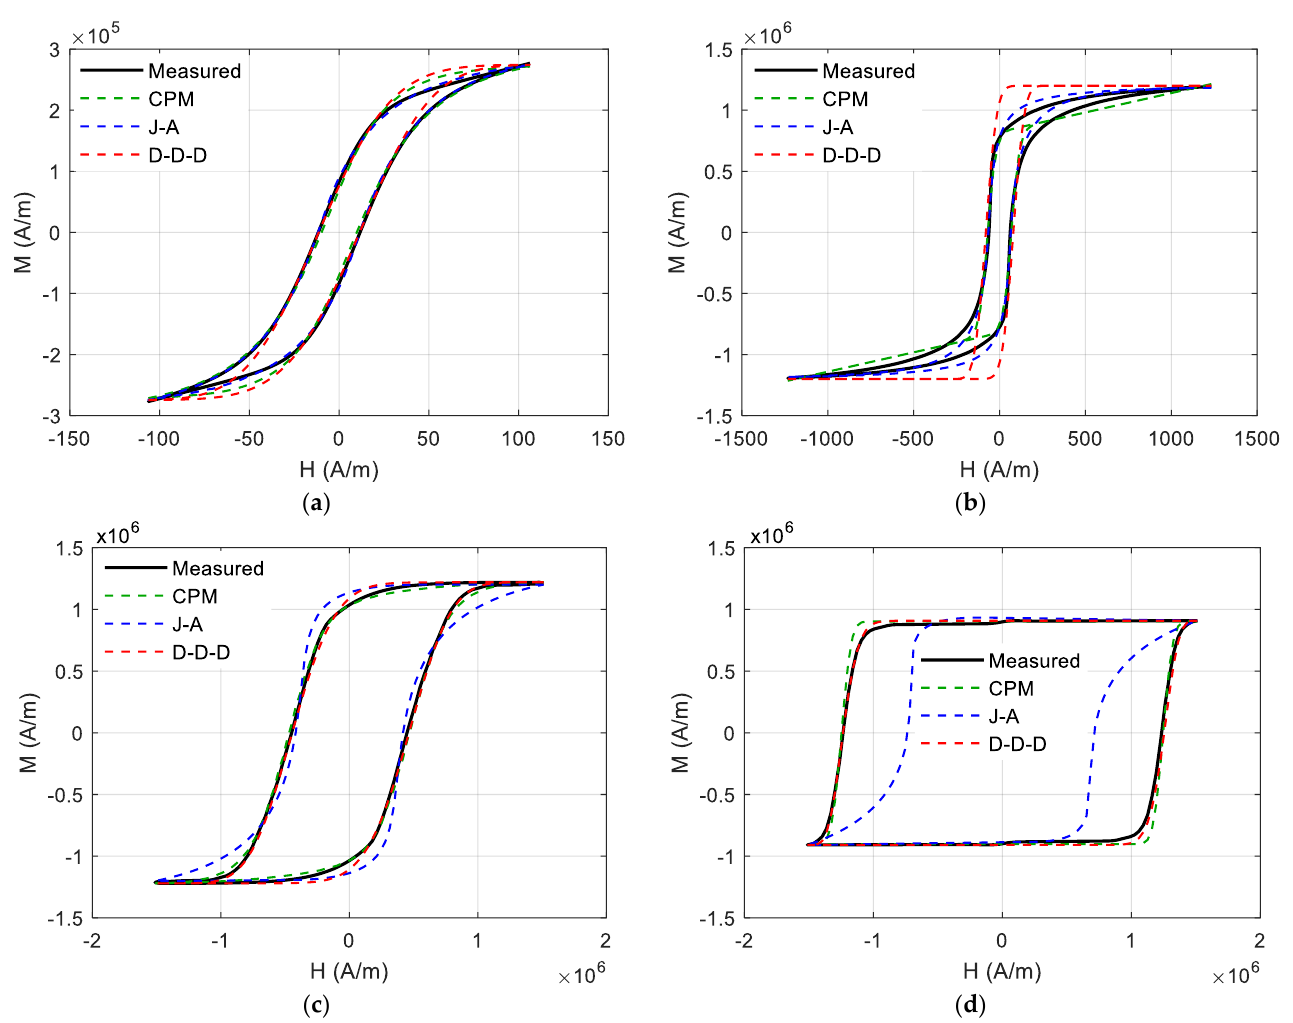
Figure 1. Comparison between measured (solid) and calculated (dashed colored) hysteresis loops. ( a ) MnZn ferrite. ( b ) Fe-Si loop 11. ( c ) NdFeB at 80 °C. ( d ) NdFeB at 27 °C.